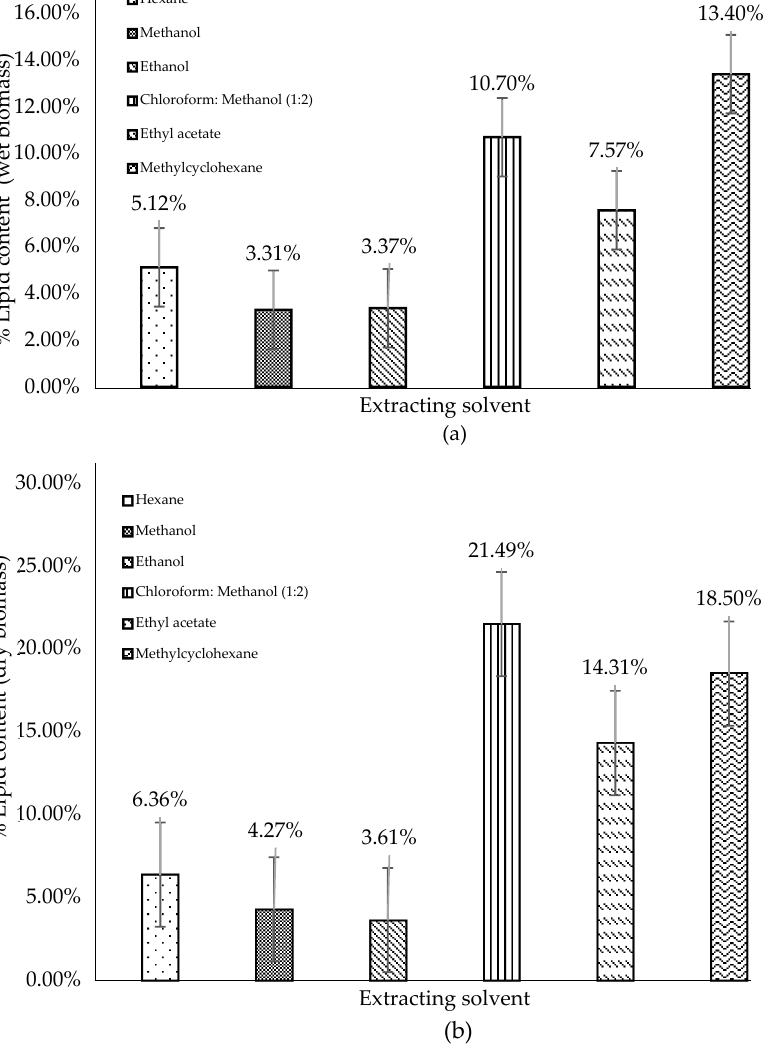
Figure 4. Lipid content of Chlorella vulgaris growth in pig slaughterhouse wastewater for 11 days in ( a ) wet biomass and ( b ) dry biomass. The values are presented as means of triplicate measures with their corresponding standard deviation (±SD).